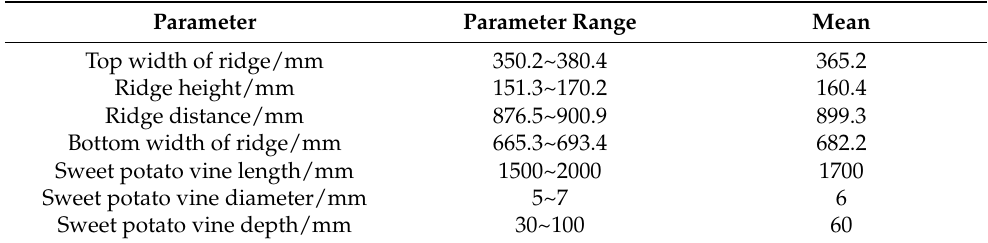
Table 1. Size parameters for a sweet potato ridge and vine during the harvest